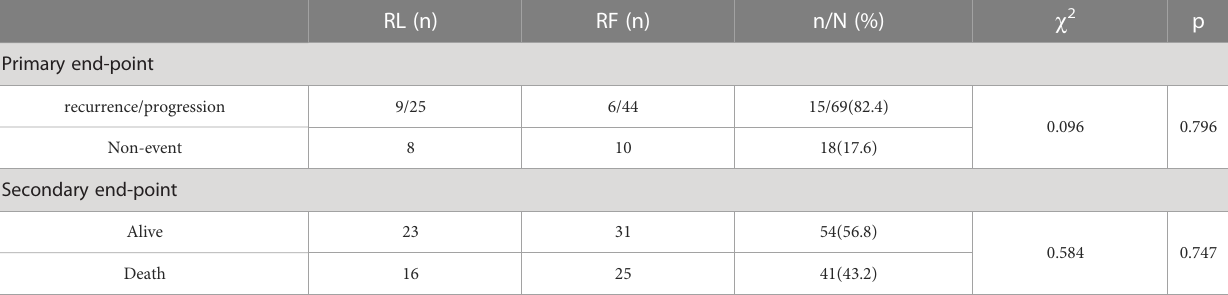
TABLE 4 End-point of R/R PCNSL after salvage